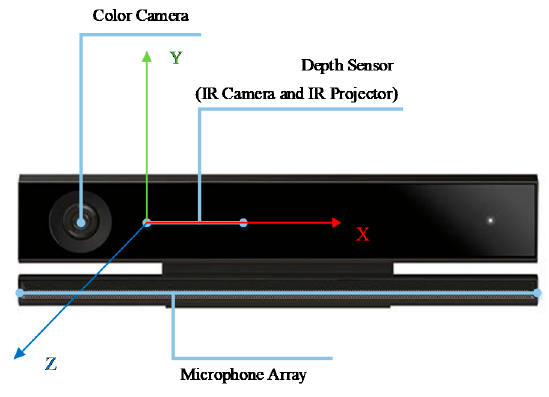
Figure 4. Kinect sensor and its coordinate system (IR means infrared).